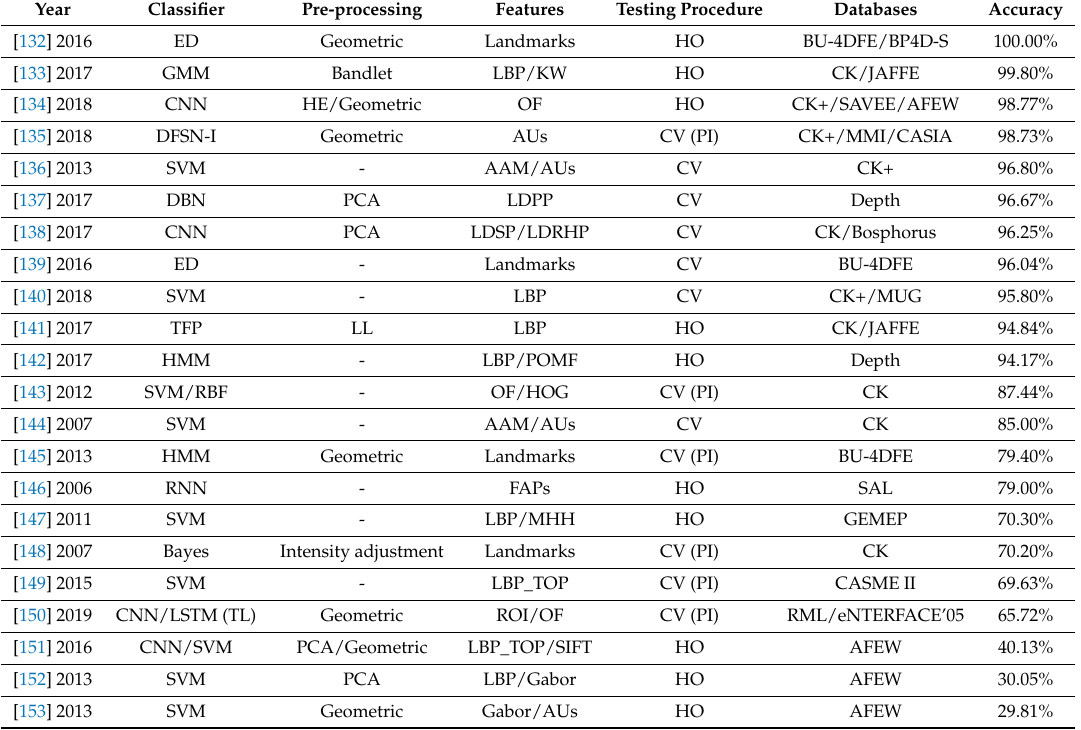
Table 3. Results of reviewed works for video